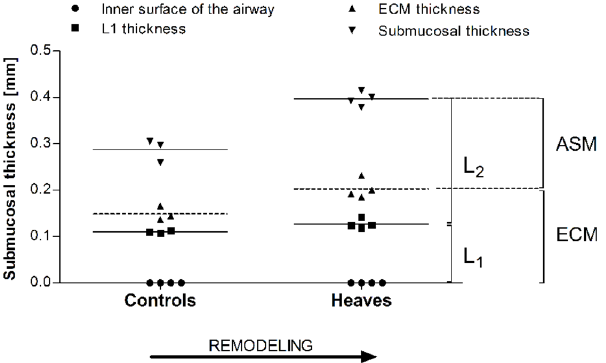
Fig 10. Composition of L2 is similar in asthmatic and control horses. The inner 25% is occupied by ECM while the remaining outer 75% is occupied by ASM. Notice that most of the ECM thickness lies behind the echo of